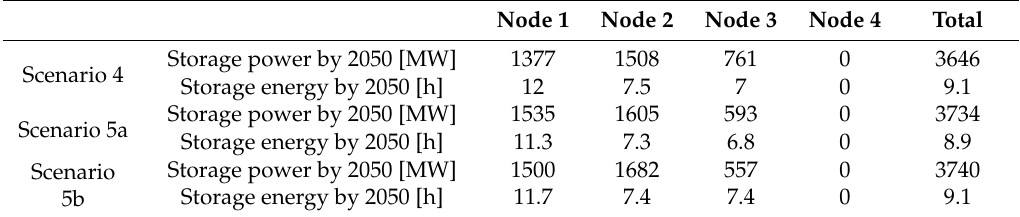
Table 8. Installed capacity of storage in year 2050 for Scenarios 4 and 5 after running the